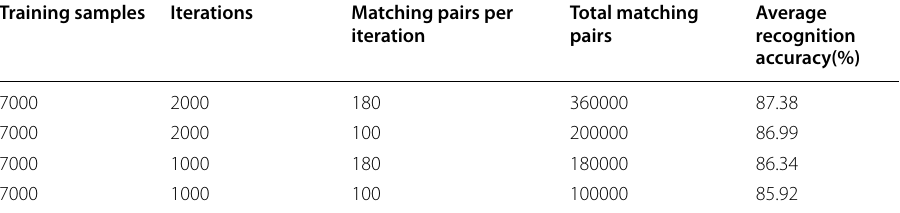
Table 4 Effects of the number of training sample and matching pair on Siamese network Training